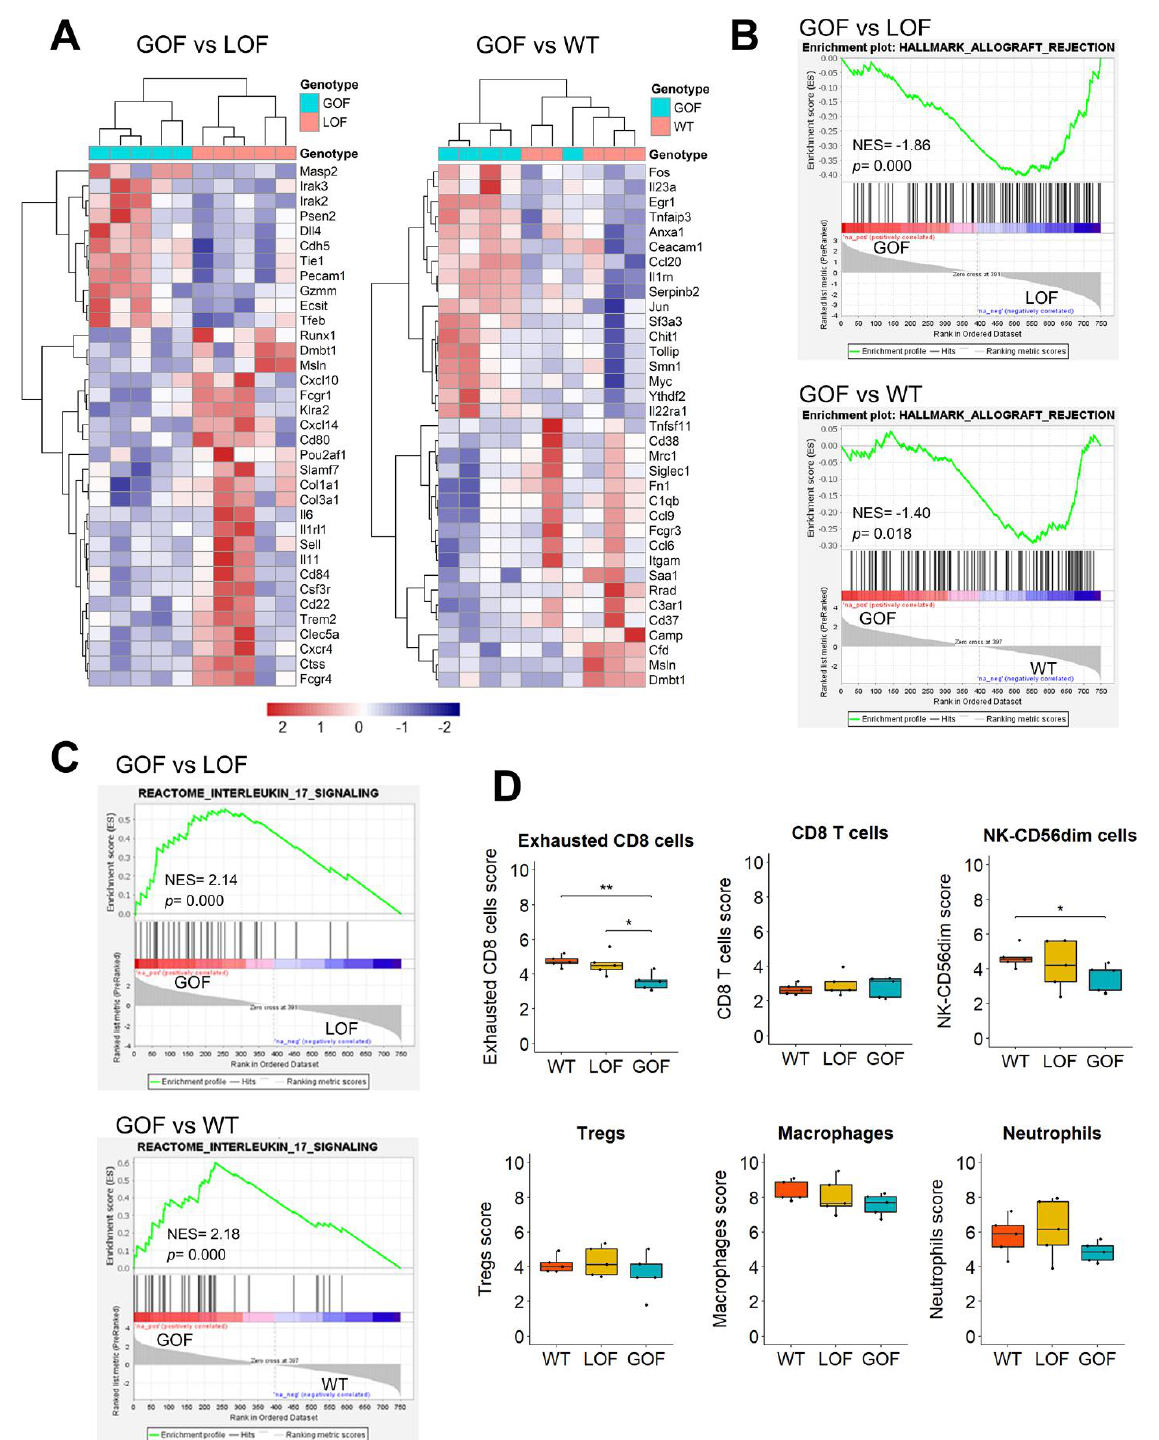
Figure 6. Upregulation of IL17 signaling and depletion of exhausted CD8 cells in p53 R172H papillomas. ( A ) Heatmap of the most differentially expressed genes between 4NQO-induced p53-GOF and p53-LOF papillomas (left panel) and between p53 -GOF and p53 -WT papillomas (right panel). ( B , C ) Gene Set Enrichment Analysis (GSEA) analysis for the gene sets ( B ) Hallmark Allograft Rejection and ( C ) Interleukin 17 Signaling in p53 -GOF vs. p53 -LOF papillomas (top panel) or between p53 -GOF vs. p53 -WT papillomas (bottom panel). ( D ) Cell type scores for the indicated immune cell populations determined by nSolver software on p53 -WT, p53 -LOF, and p53 -GOF papillomas. * p < 0.05, ** p <